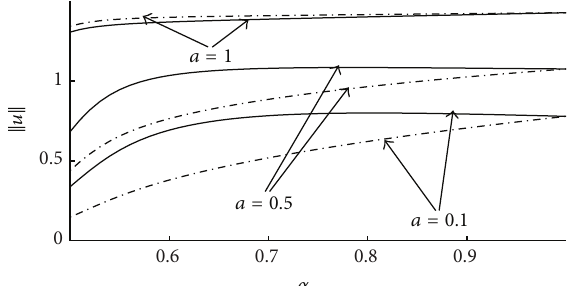
Figure 7: The dependencies for control norm from 𝛼 at 𝑝 󸀠 = 2 and different values of parameter 𝑎